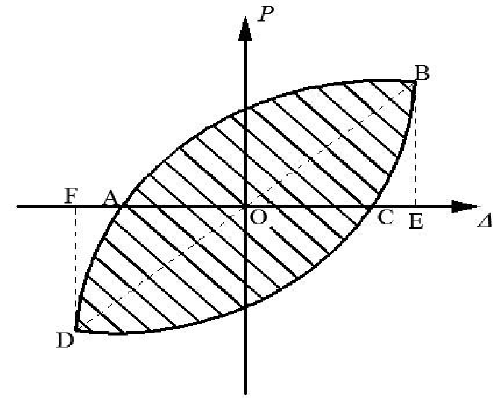
h . Figure 10. Calculation diagram of equivalent viscous damping coefficient h e